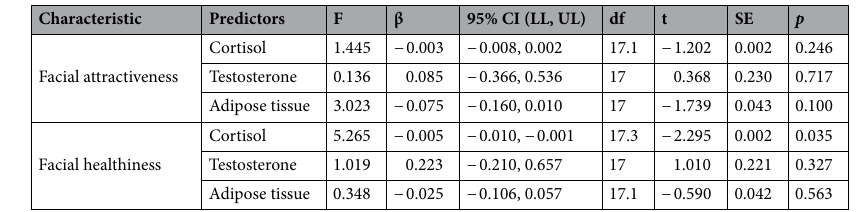
Table 4. Relationship between perceived facial attractiveness and healthiness, cortisol, testosterone levels, and adipose tissue. Attractiveness ratings: for target ID, VRC = 0.763, SD = 0.873, ICC = 0.374; for rater ID, VRC = 0.429, SD = 0.655, ICC = 0.251. Relationship between facial healthiness and cortisol, testosterone levels, and percentage of adipose tissue. Facial healthiness ratings: for target ID, VRC = 0.690, SD = 0.831, ICC = 0.320; for rater ID, VRC = 0.458, SD = 0.676, ICC = 0.238. VRC variance of random